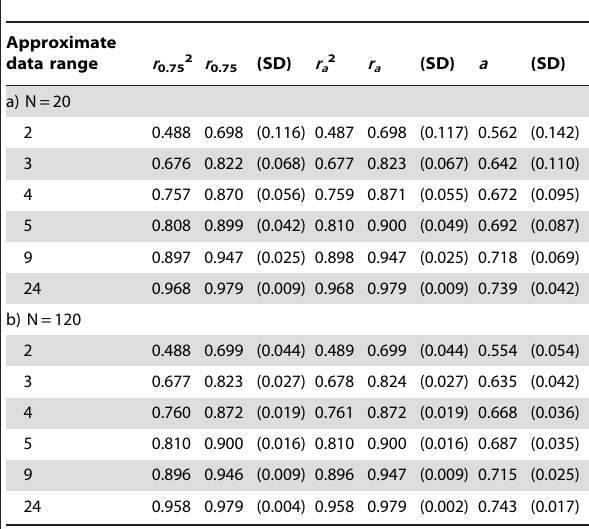
Table 1. The fit of allometric models with either a fixed (subscript 0.75) or an empirical scaling exponent (subscript a